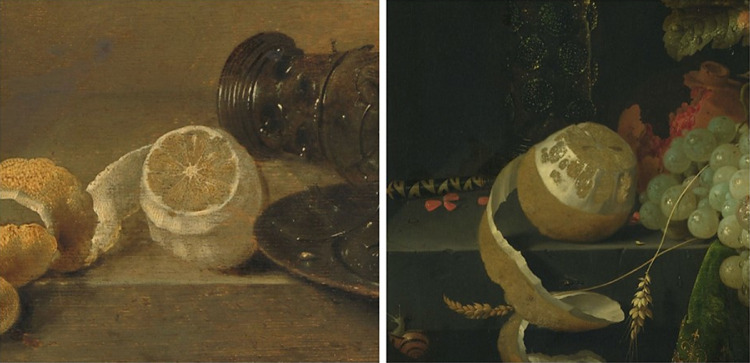
Examples of two stimuli with the seeds visible inside the pulp. The one on the left was perceived to be among the least translucent and least juicy, whereas the one on the right was rated as being highly translucent and juicy. (Left) Willem Claesz Heda, Still Life with a Broken Glass (1642); (right) Abraham Mignon, Still Life with
Fruit
and a Beaker on a Cock's Foot (1660–1679). The images were downloaded from the online repository of the Rijksmuseum, Amsterdam.